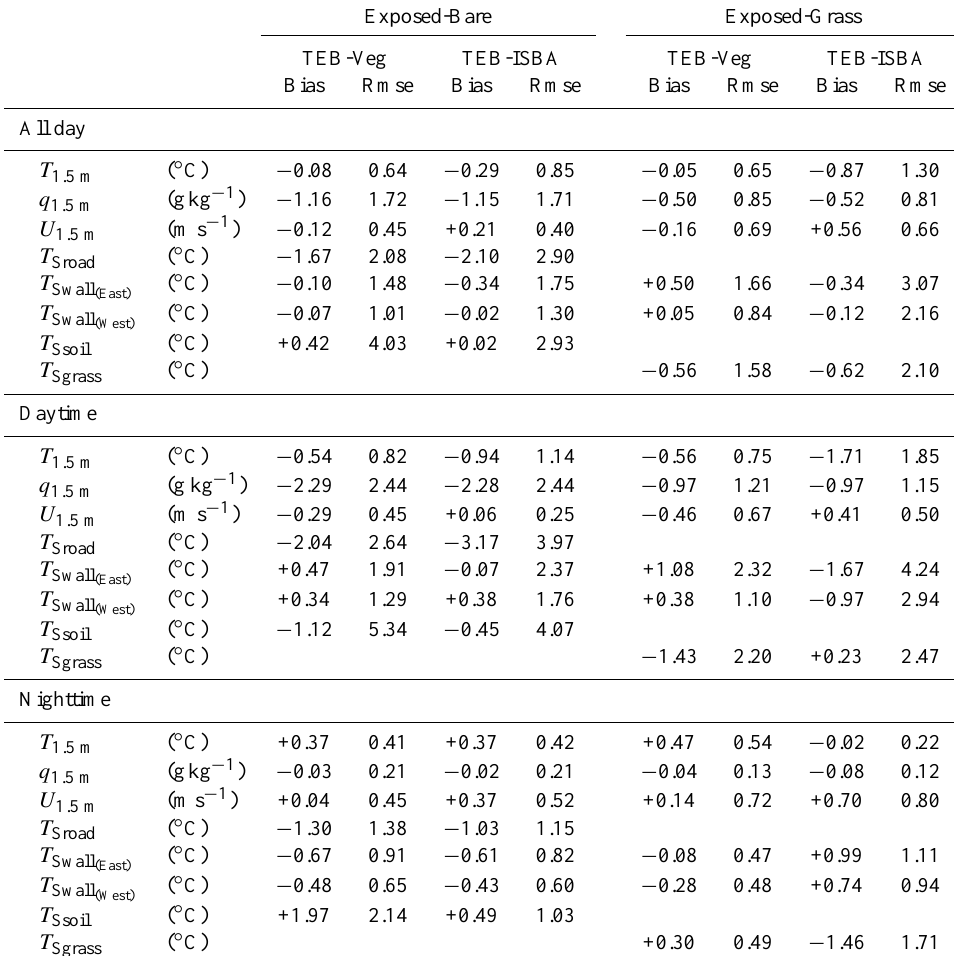
Table 3. Bias (Model-Obs) and root-mean-square error in temperature, humidity, and wind speed at 1.5ma.g.l., and in surface temperatures of impervious and pervious covers. The scores are calculated for TEB-Veg and TEB-ISBA for both Exposed-Bare and Exposed-Grass experiments over the whole day, daytime hours (06:00–18:00LST), and nighttime hours